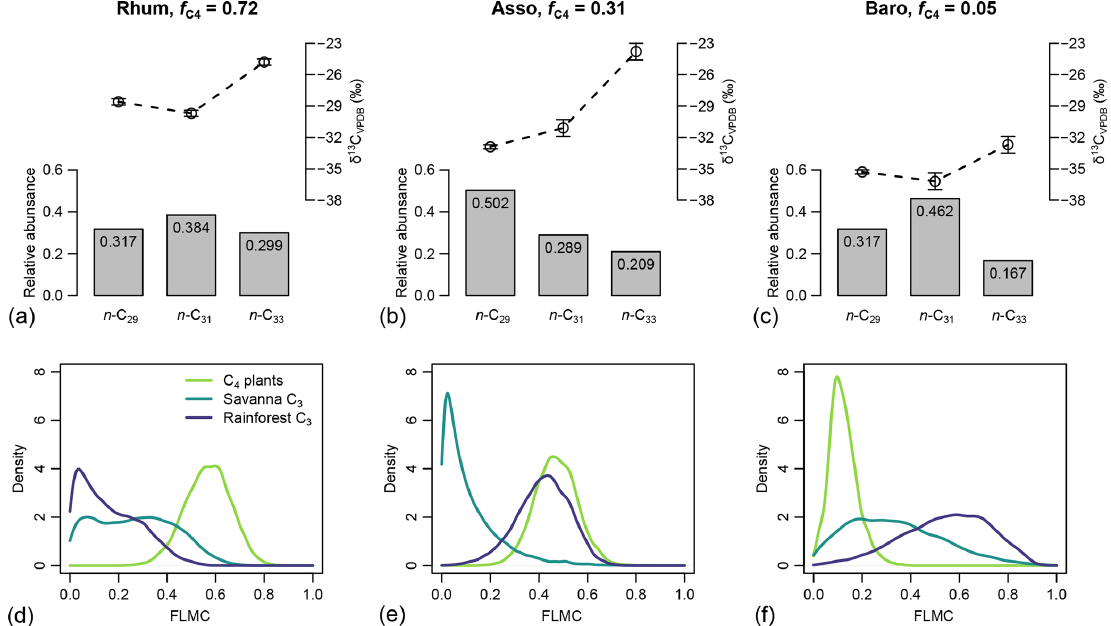
Figure 8. (a–c) Sedimentary long-chain n -alkanes ( n -C 27 , n -C 29 and n -C 31 ), their δ 13 C (‰, VPDB), and relative abundance values (ex- cluding other chains) in published lake surface sediment samples from Cameroon (Garcin et al., 2014). (d–f) Posterior densities of fractional leaf mass contribution (FLMC) of tropical C 4 plants, savanna C 3 plants, and rainforest C 3 plants as model output conditioned on the δ 13 C and relative abundance values. Table 4. The maximum a posteriori probability estimates (MAPE), the medians, and the 89% highest density intervals (HDI) of posterior densities of the fractional leaf mass contributions (FLMCs) as model output using data in published lake surface sediment samples from Cameroon (Fig.